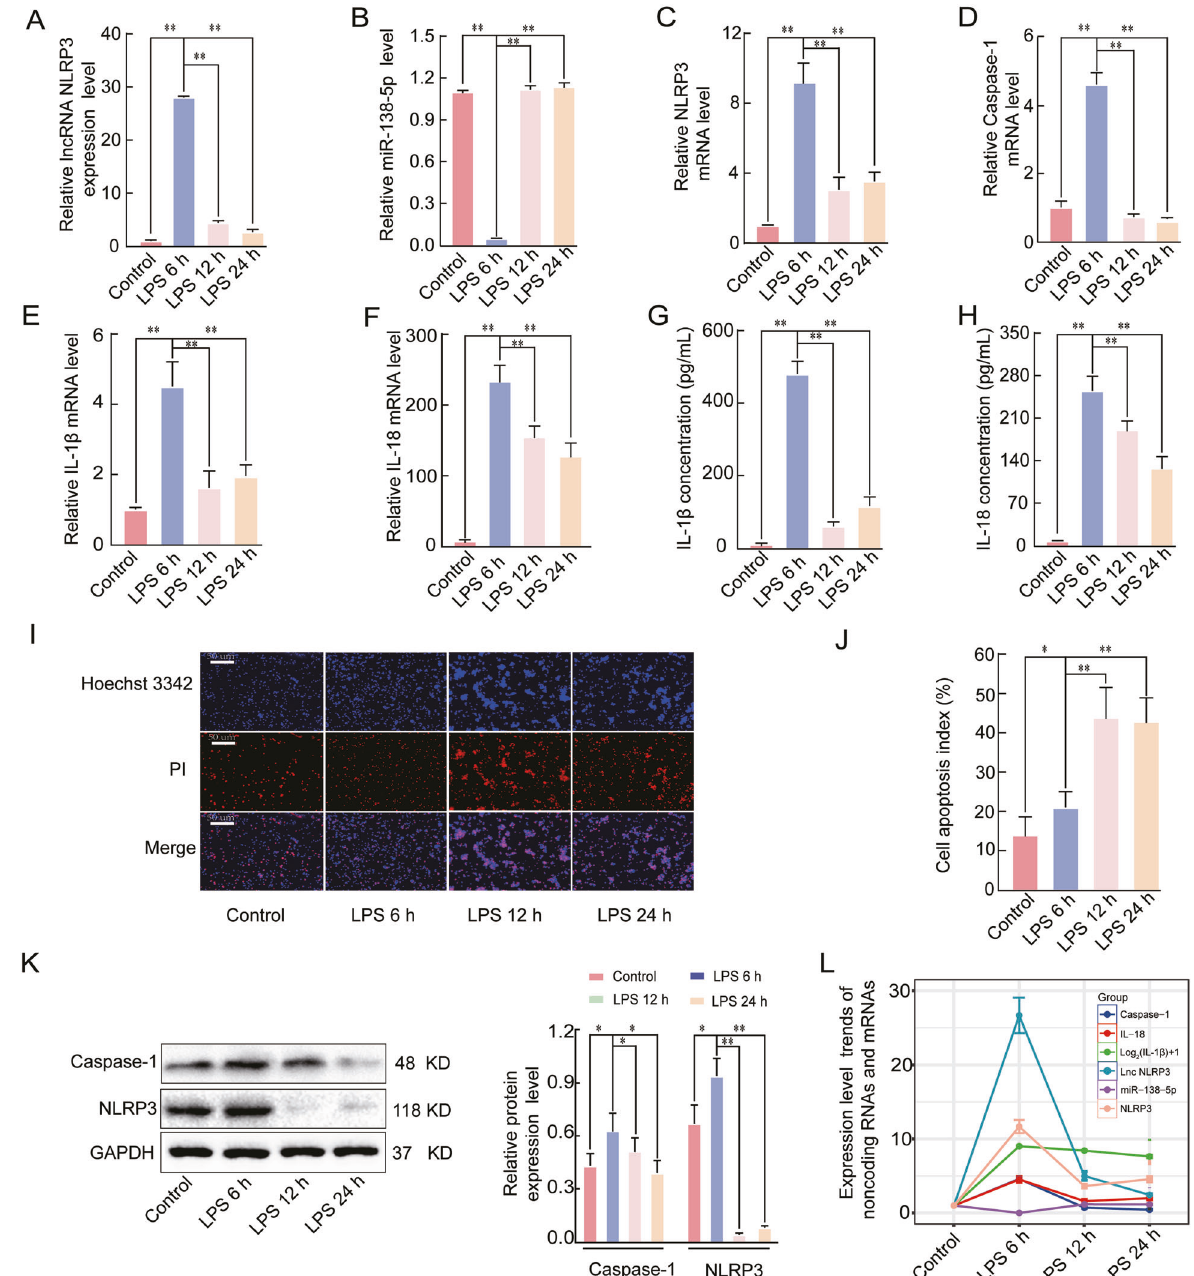
Fig. 2 Effects of LPS on the lncRNA NLRP3, miR-138-5p, NLRP3, Caspase-1, IL-1 β , and IL-18 expression levels in early ALI. A qRT-PCR assay was used to analyse the mRNA expression of A LncRNA NLRP3, B miR-138-5p, C NLRP3, D Caspase-1, E IL-1 β , and F IL-18 in LPS-induced ALI. β -Actin was used as the reference gene. G , H ELISA analysis of the IL-1 β and IL-18 levels in the culture supernatant. Cell apoptosis was determined by Hoechst 33342 and PI dual staining assays ( I ) and counted ( J ). The expression of NLRP3 and caspase-1 in the NR8383 AM cells from the four groups was analysed by western blotting ( K ). L Expression trends of lncRNA NLRP3, NLRP3, caspase-1, IL-1 β , IL-18, and miR-138- 5p in the negative control group and groups treated with LPS for 6, 12, and 24 h. The data are presented as mean ± SE ( n = 6). * P < 0.05; ** P < 0.01; *** P < 0.001; NS, no statistically signi fi cant